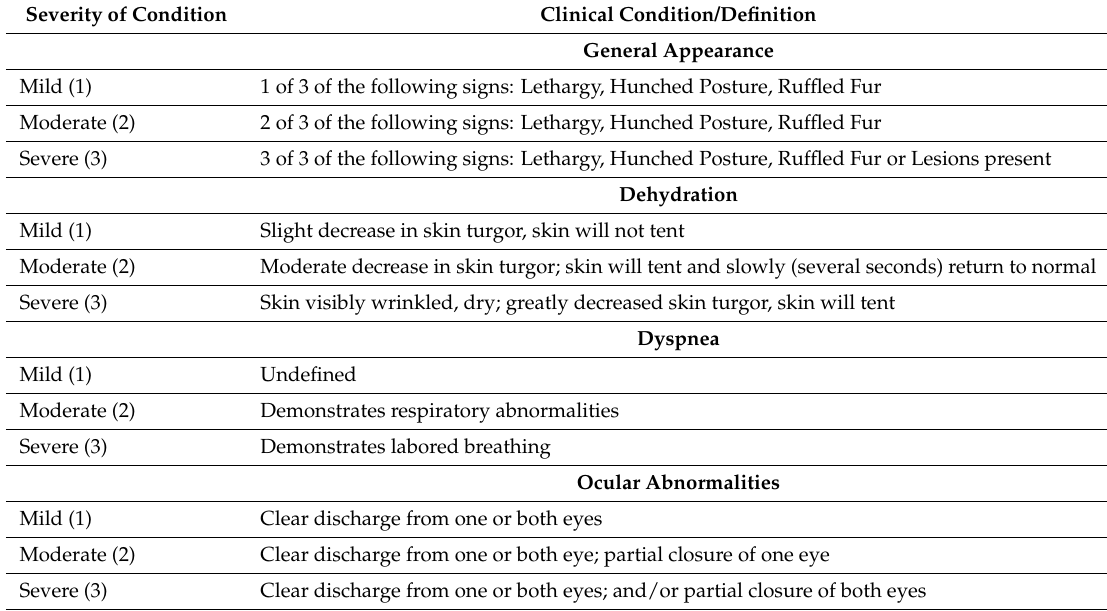
Table 2. Clinical conditions and